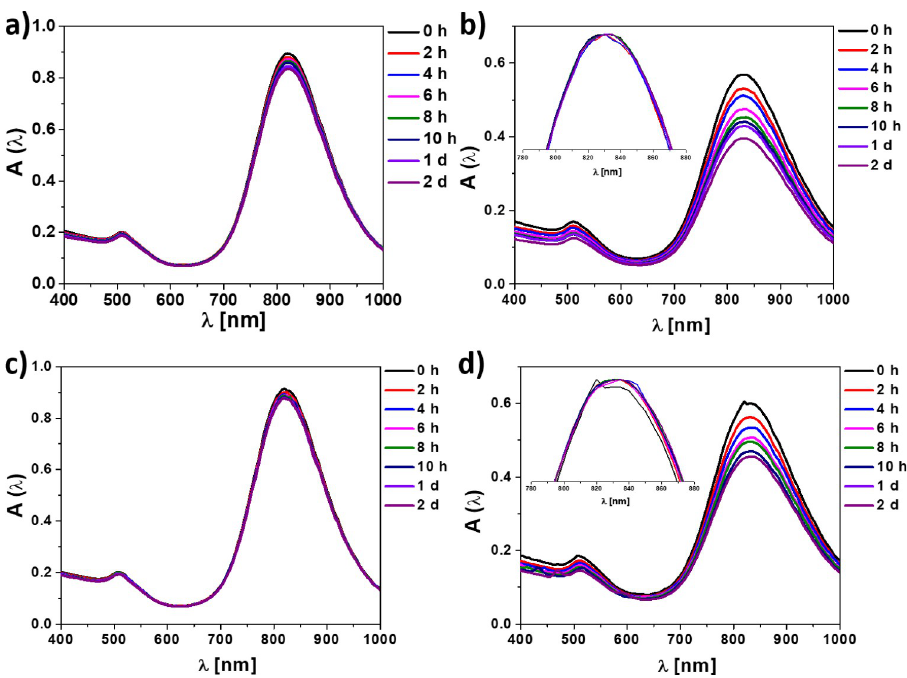
Fig 2. Abs-GNRs show specific association with A β 40 fibrils and seeds. Absorption spectra (not normalised) of a) PMA-GNRs with A β -seeds, b) Abs-GNRs with A β -seeds, c) PMA-GNRs with A β fibrils, and d) Abs-GNRs with A β fibrils in water at different time-points as shown. Loss of intensity is observed due to conjugation with insoluble A β seeds and fibrils. Insets show normalised spectra.